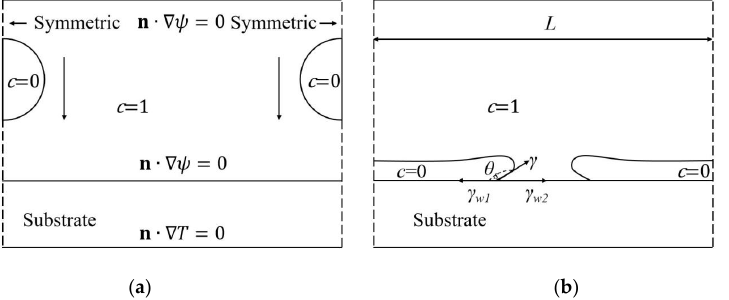
Figure 1. Problem schematic with boundary conditions defined. ( a ) is the initial configuration and ( b ) is of some time later. ( b ) is of some time